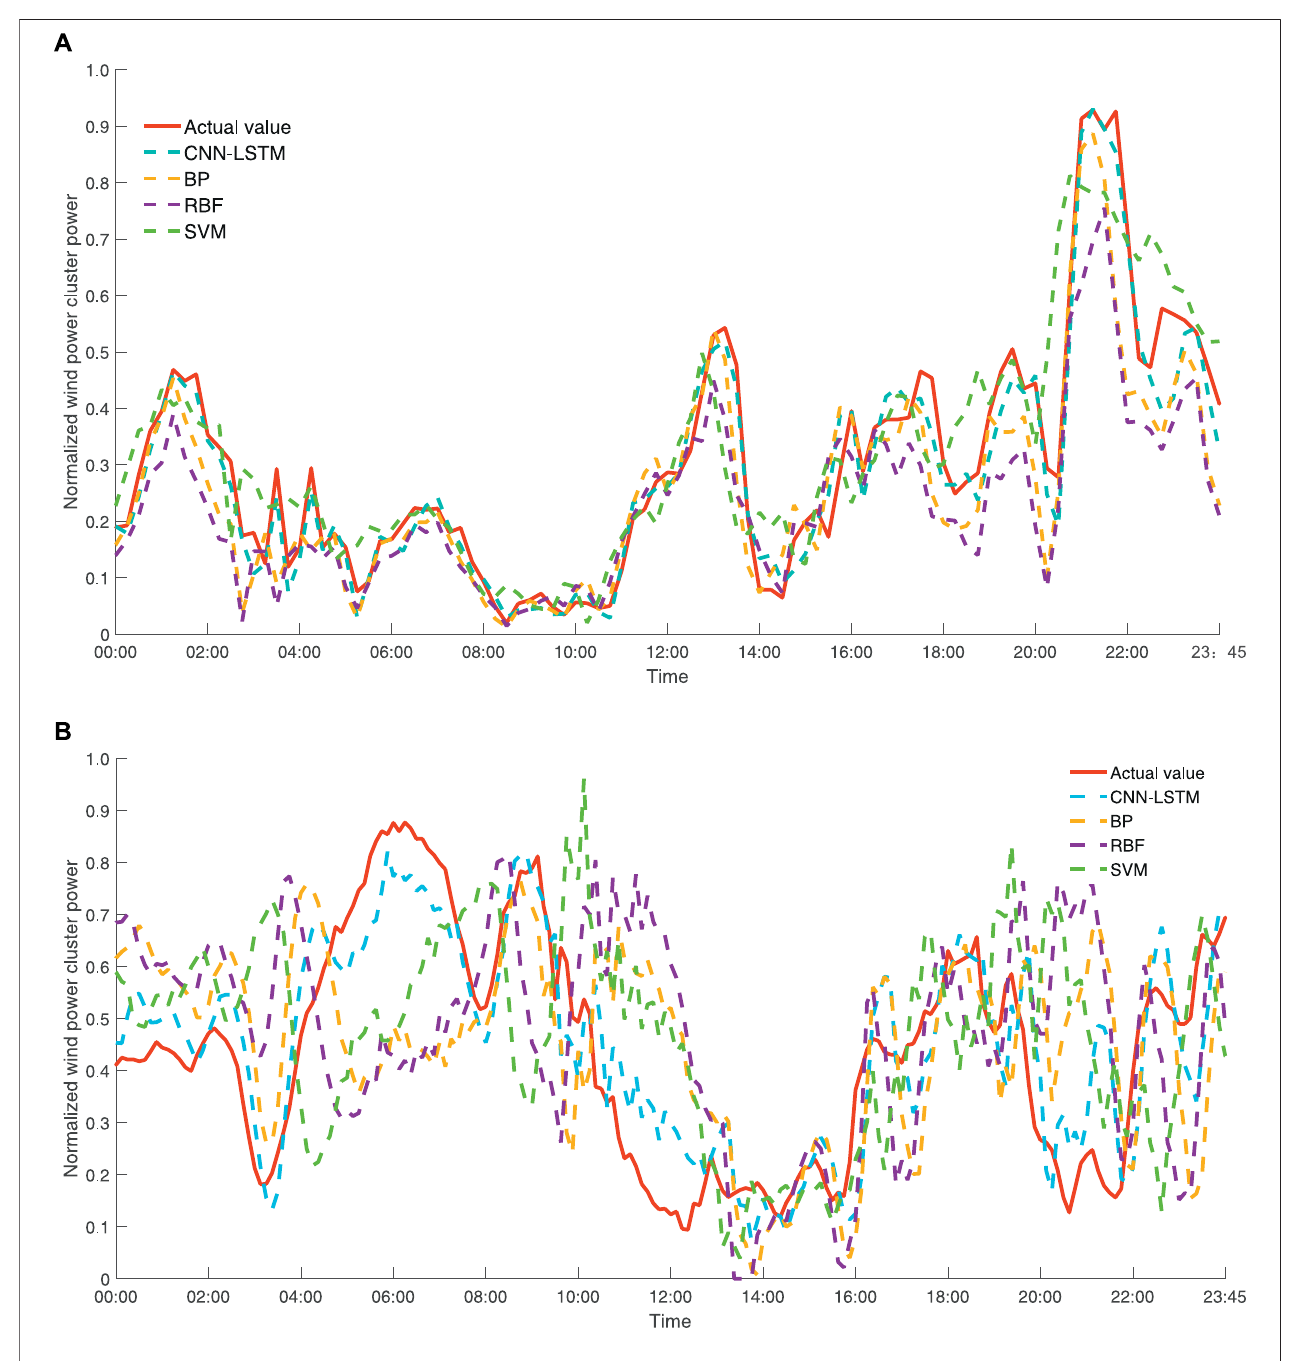
FIGURE 8 | Forecast effect of the 10th day of each season in 2018. (A) Spring (B) Summer (C) Fall (D) Winter.